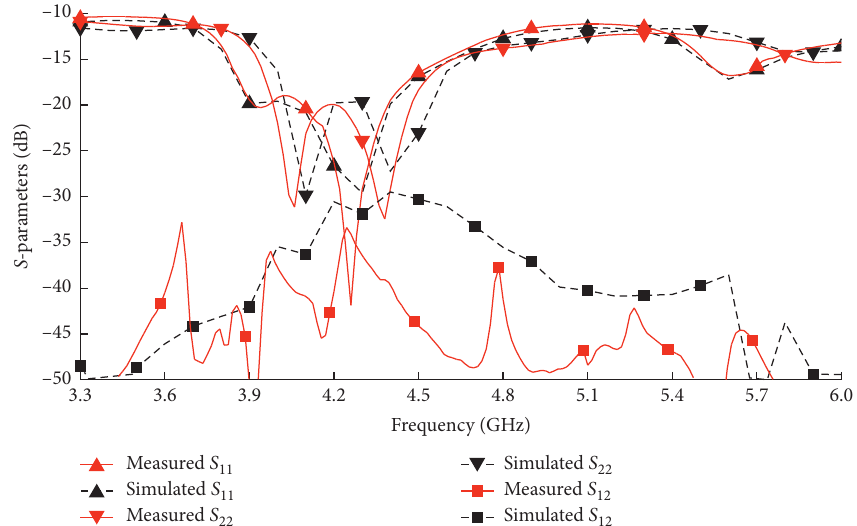
Figure 15: Simulated and measured ( S )-parameters of the antenna